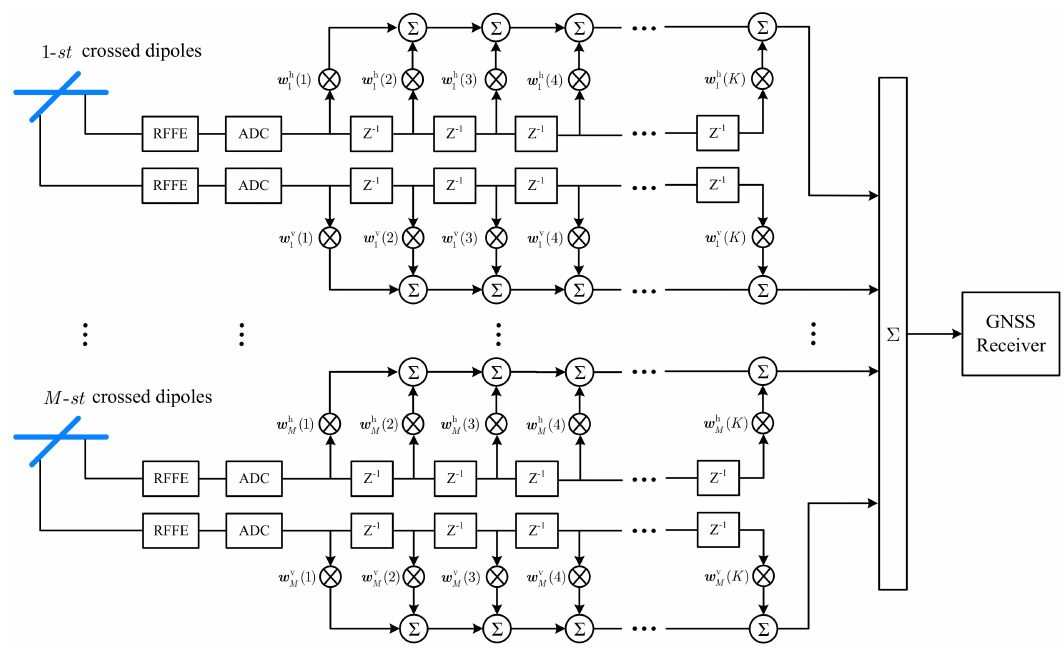
Figure 2. The STPAP architecture using the